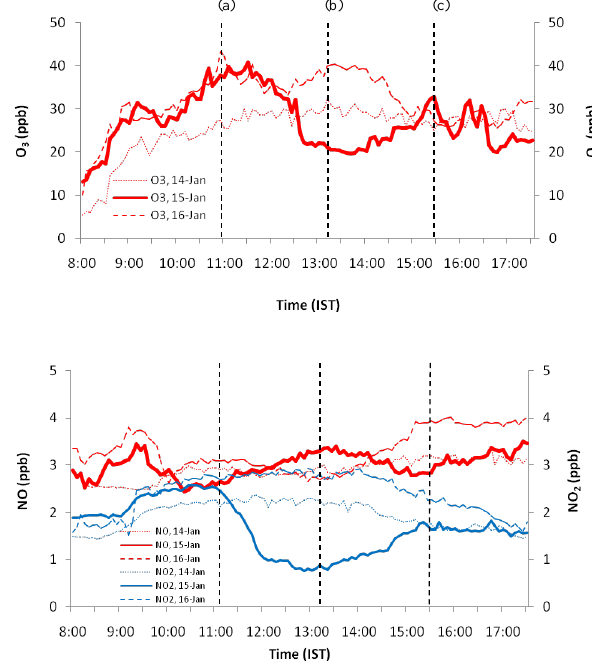
479 Figure 1: : Solar radiation, wind speed, ambient temperature and relative humidity measured 480 Fig. 1. Solar radiation, wind speed, ambient temperature and rel- before, during and after the total solar eclipse occurred on 15 January, 2010 at 481 Thiruvananthapuram, India, (a) beginning of the solar eclipse, (b) solar eclipse 482 ative humidity measured before, during and after the total solar maximum, (c) end of the solar eclipse along with a day before and a day after of the 483 solar eclipse. 484 eclipse occurred on 15 January 2010 at Thiruvananthapuram, In- 485 dia, (a) beginning of the solar eclipse, (b) solar eclipse maximum, 486 487 (c) end of the solar eclipse along with a day before and a day after of the solar eclipse.